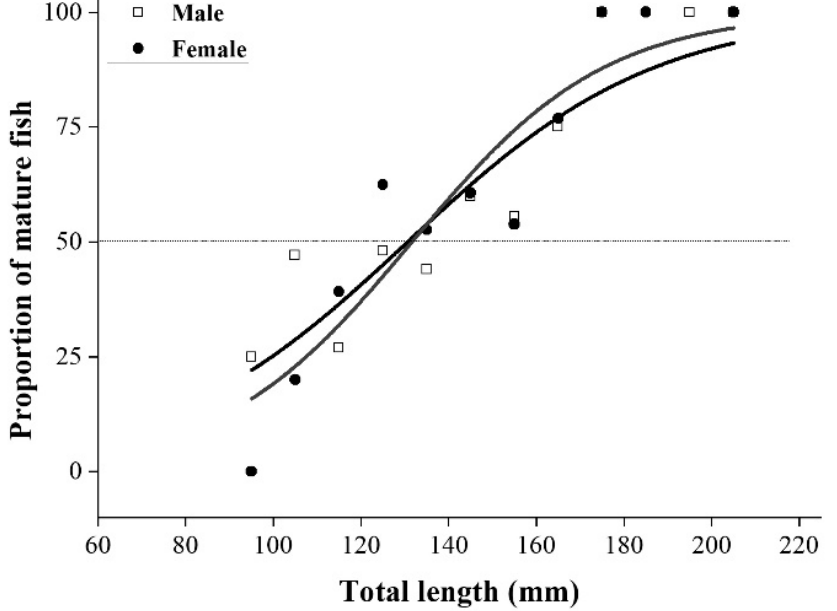
Figure 5. Logistic functions for Pseudecheneis sulcatus fitted to cumulative percentage of sexual maturity in samples in relation to size.